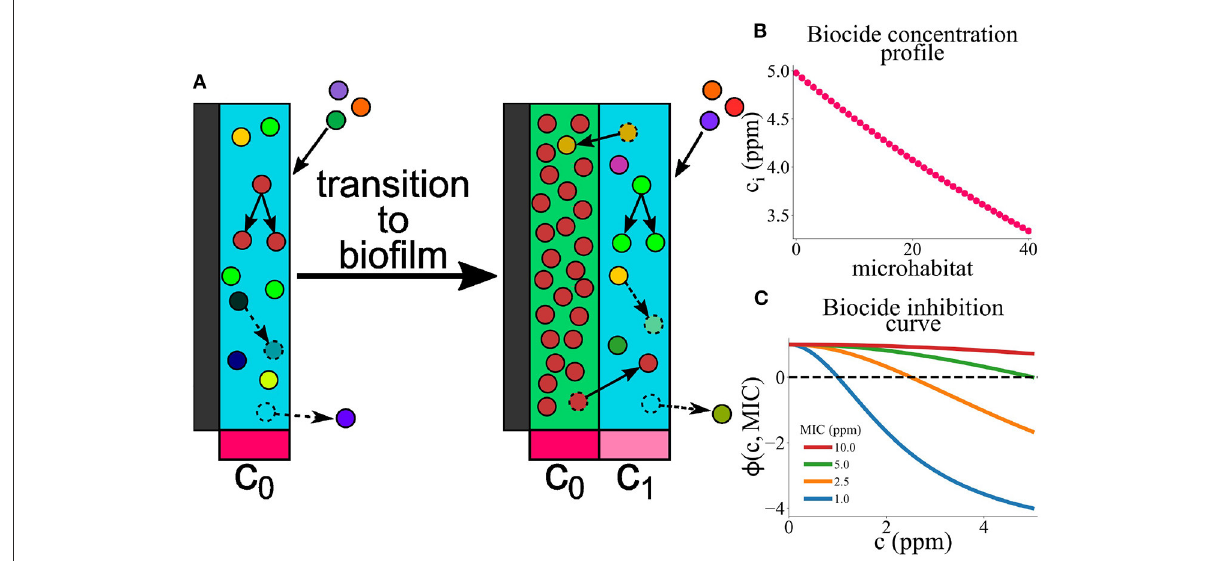
FIGURE1 (A) A model for microbial colonization of an AF surface. Microbes immigrate from the well-mixed marine environment into the edge microhabitat. They can replicate, die, migrate between adjacent microhabitats, or detach from the edge microhabitat. Once the population of the edge microhabitat reaches a threshold size, a new edge microhabitat is added. This creates an expanding series of microhabitats, representing the growth of a marine biofilm. Each microhabitat i contains a concentration of biocide, c i , which decreases exponentially with distance from the surface. (B) Biocide concentration c i as a function of microhabitat index i . The biocide concentration has a maximum value c max (here 5 ppm), and decreases exponentially in successive microhabitats; note that we only simulate up to a system size of 40 microhabitats. (C) Biocide inhibition curves (pharmacodynamic function φ ) as a function of biocide concentration c for microbes with MIC values between 1 and 10 ppm. Positive values of φ indicate microbial growth; negative values of φ indicate microbial death. The dashed black line represents the boundary between microbial growth and death. Microbes with lower MIC values are more susceptible to the biocide and therefore die at lower biocide